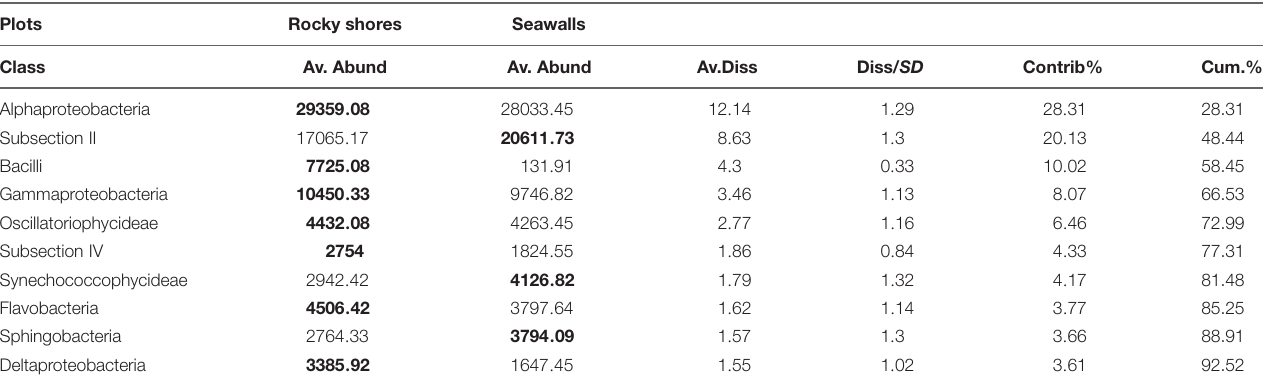
TABLE 3 | Results of SIMPER analysis giving dissimilarities among habitats sampled from plots.